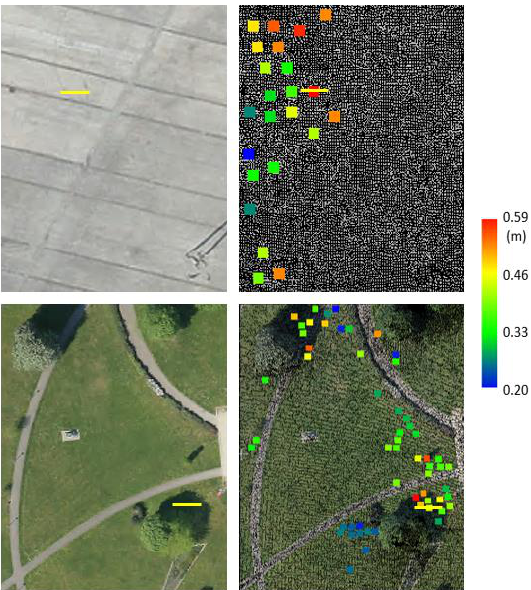
Figure 5. Visualization of the HRR values for the wrongly filtered patches in the SURE points. Top: 23 patches on the paved ground; Bottom: 58 patches on the grassland.